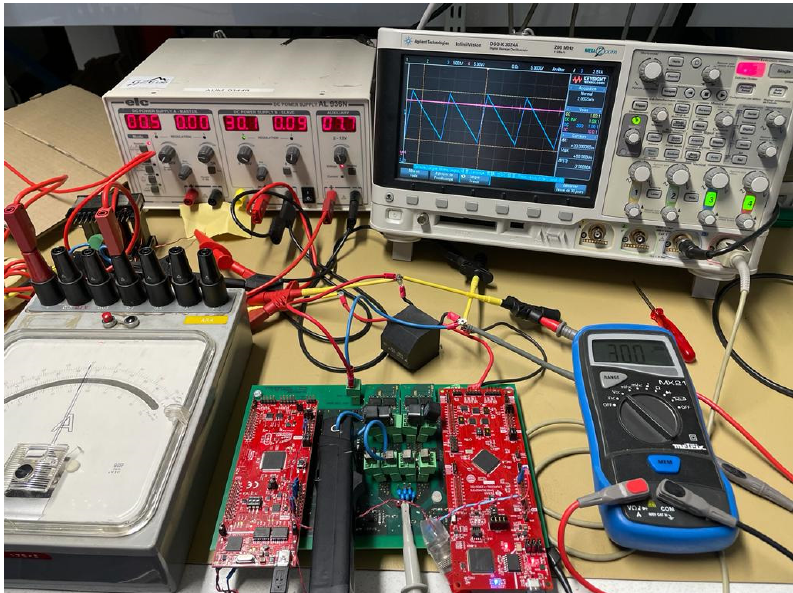
Figure 26. Picture of the test bench with the two TI controllers, one for each converter and in between the two converters, one feeding the other.